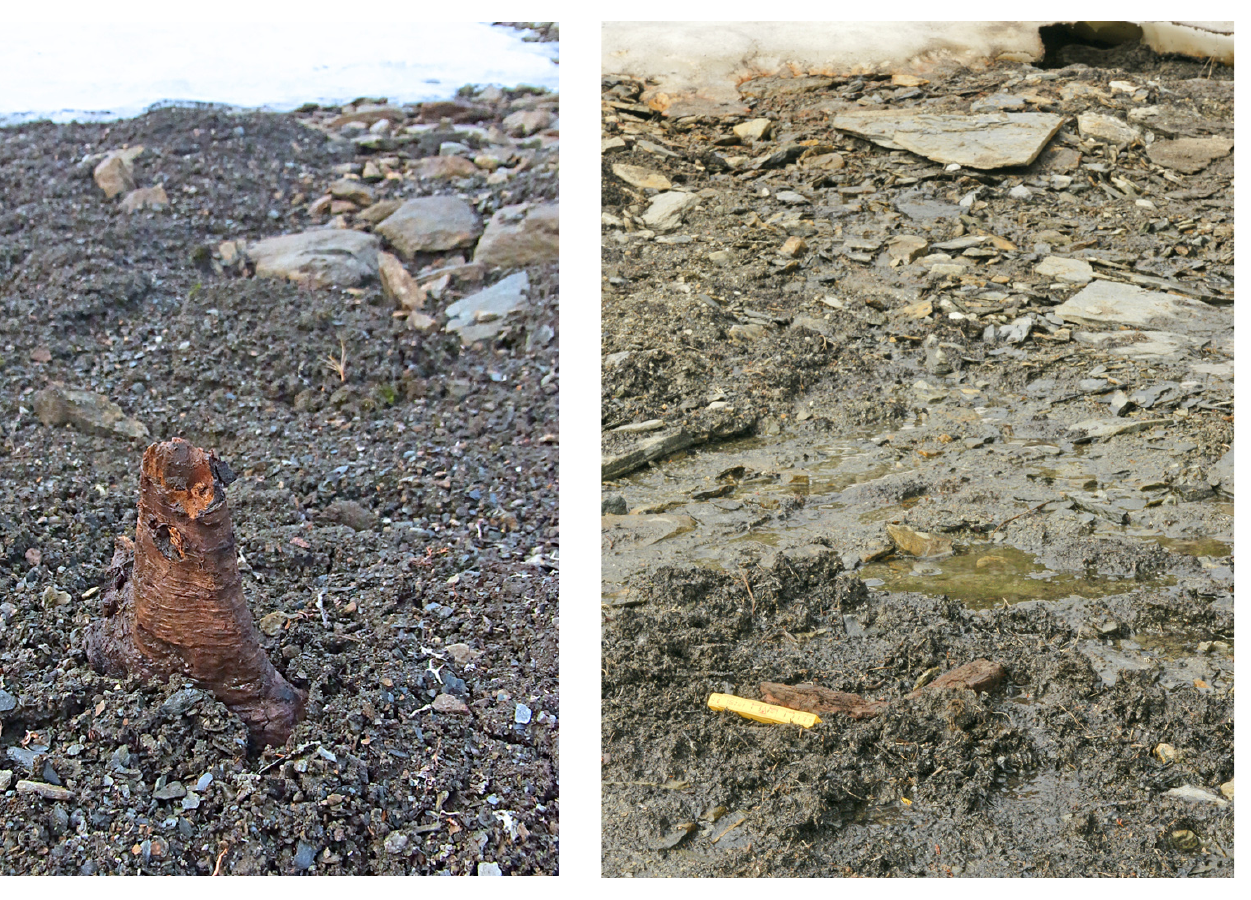
Figure 21: Slåttatjåkka (9). Wood pieces of birch in a thick layer of snow patch loess. 9130 cal. yr BP (Beta 264392).